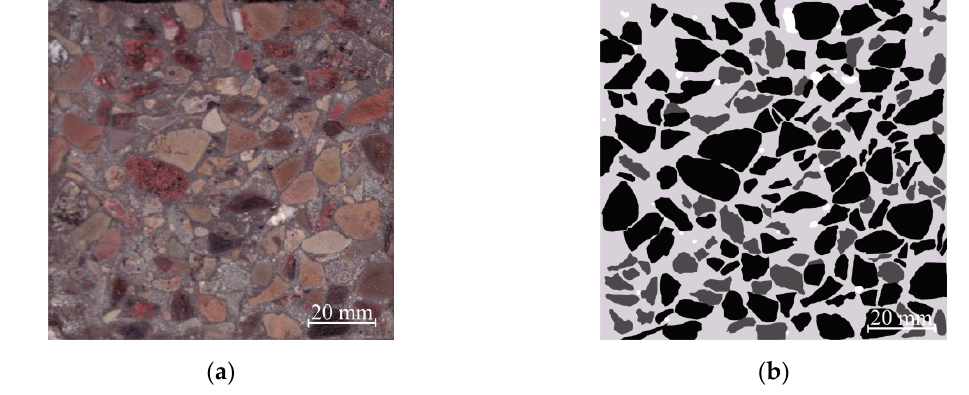
Figure 7. View of the concrete sample CW1, ( a ) scanned; ( b ) analyzed by employing computer graphic software: white color is used to indicate pores; light gray—newly created cement stone with fine aggregate; dark gray and black—concrete waste (dark gray—cement stone with fine aggregates and black—coarse aggregates).